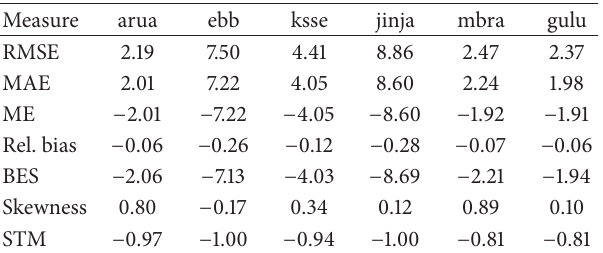
Table 1: Statistical bias measures of actual and model simulation for maximum temperatures.